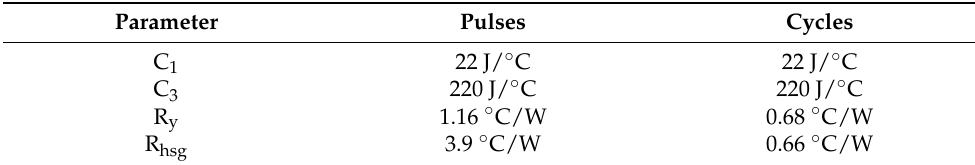
Figure 17. Simplified split-phase LPTN. Table 3. Optimal thermal parameters of the simplified phase-split LPTN.